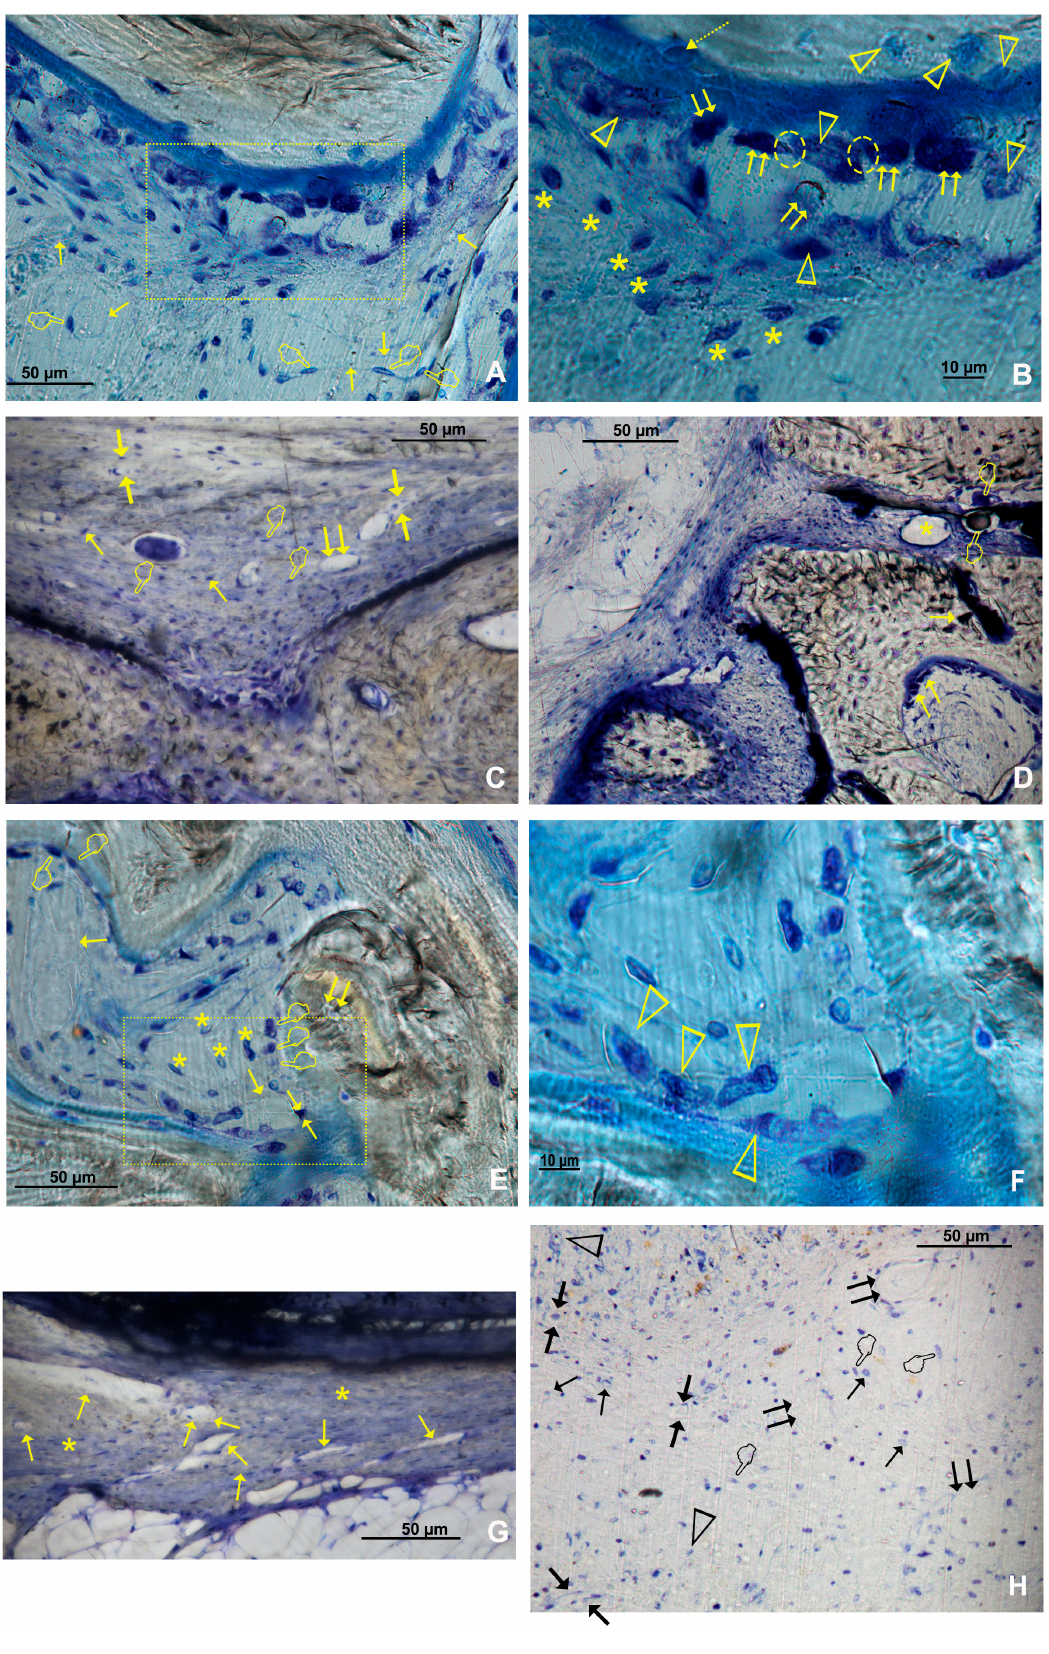
Figure 5. ( A ) Bone histology image obtained after using Zn-Si-M, at R1 region, by dye with toluidine blue to visualize bone cells and vascular vessels, at six weeks of healing time. The single arrows